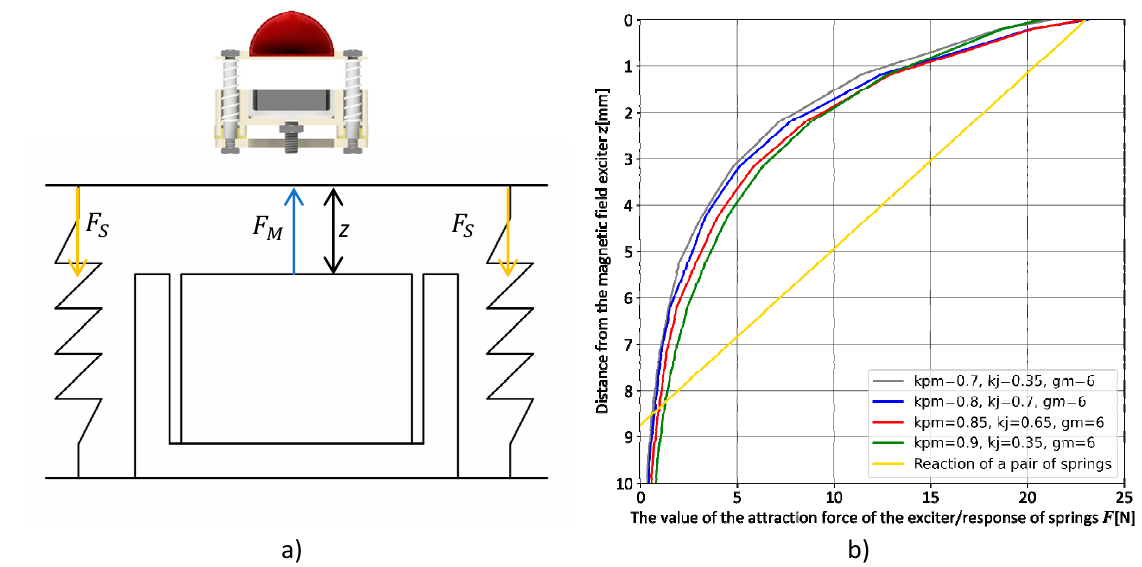
Figure 17. The value of the attraction force of the exciter as a function of the change in the distance of the magnetic field source z for selected geometry configurations in conjunction with spring reaction: ( a ) graphical explanation; ( b ) chart.